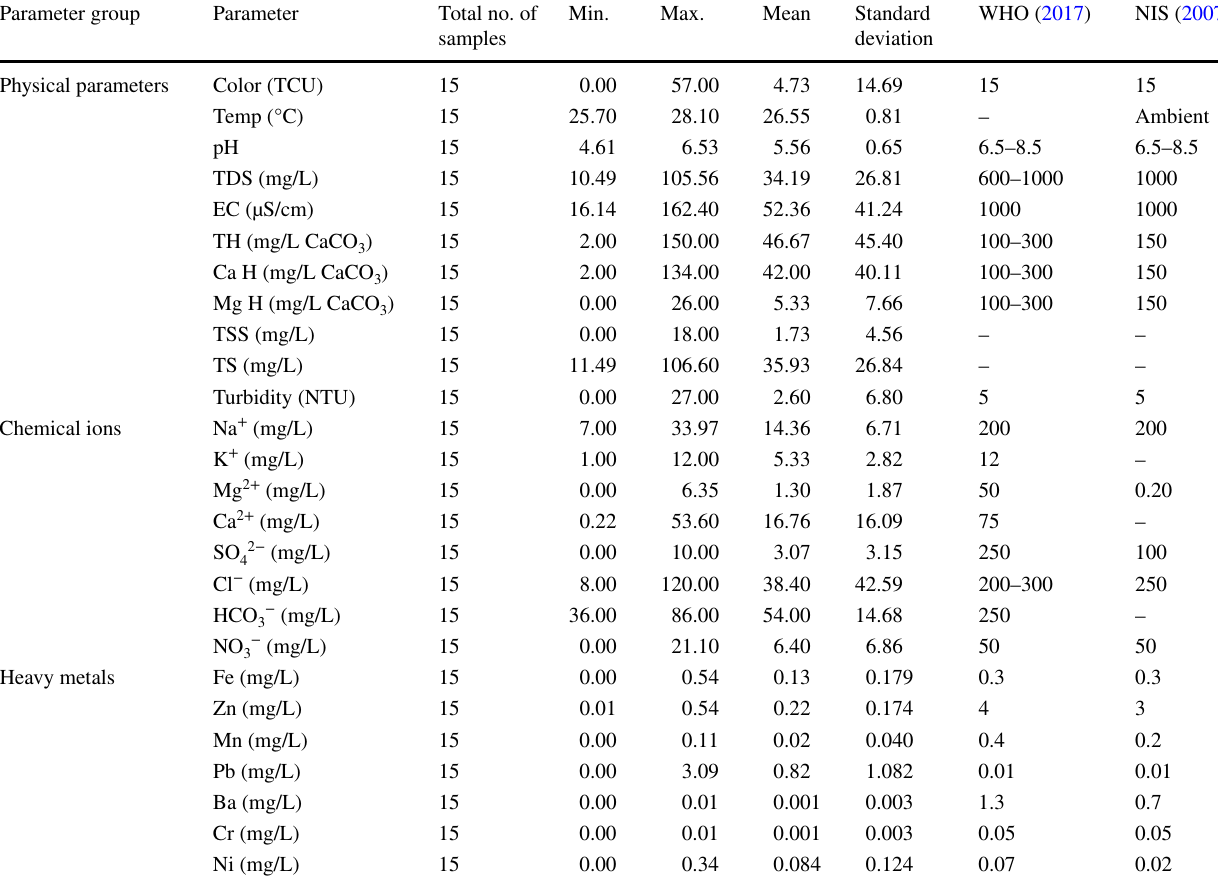
Min. Max. samples